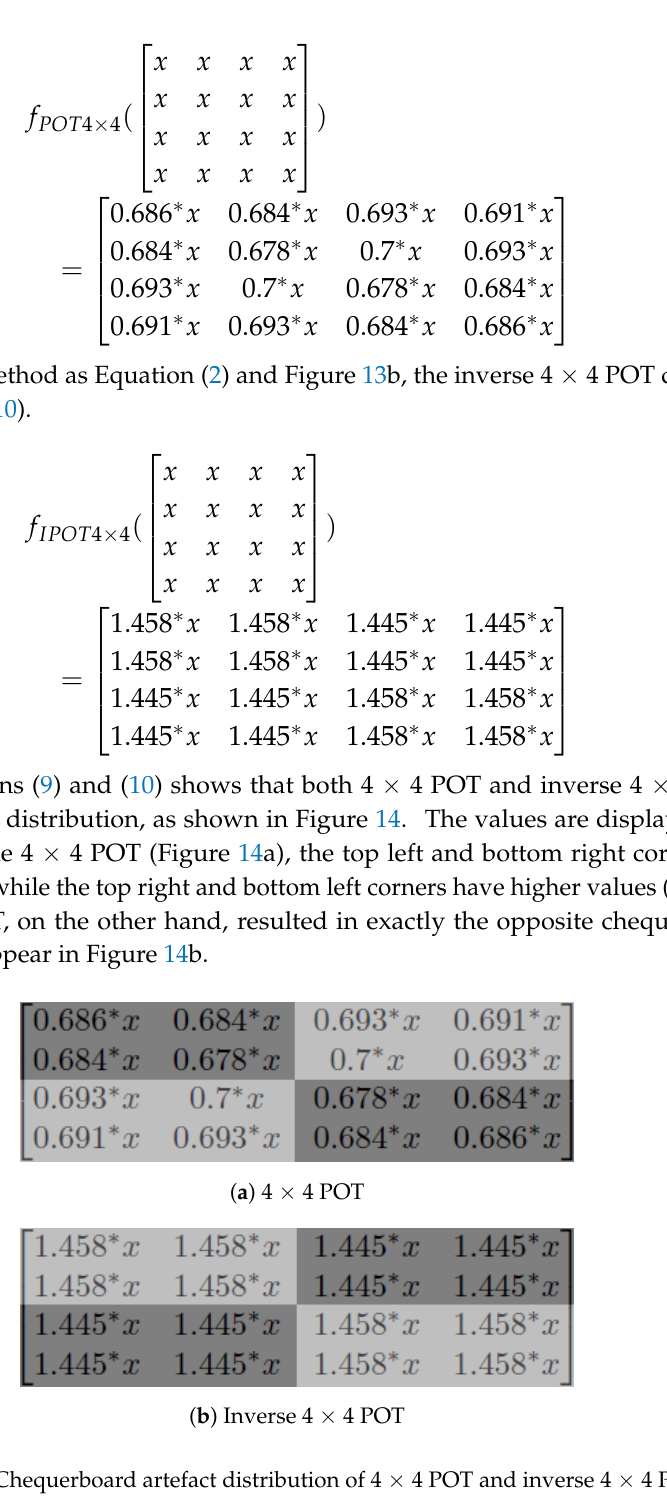
Figure 14. Chequerboard artefact distribution of 4 × 4 POT and inverse 4 × 4